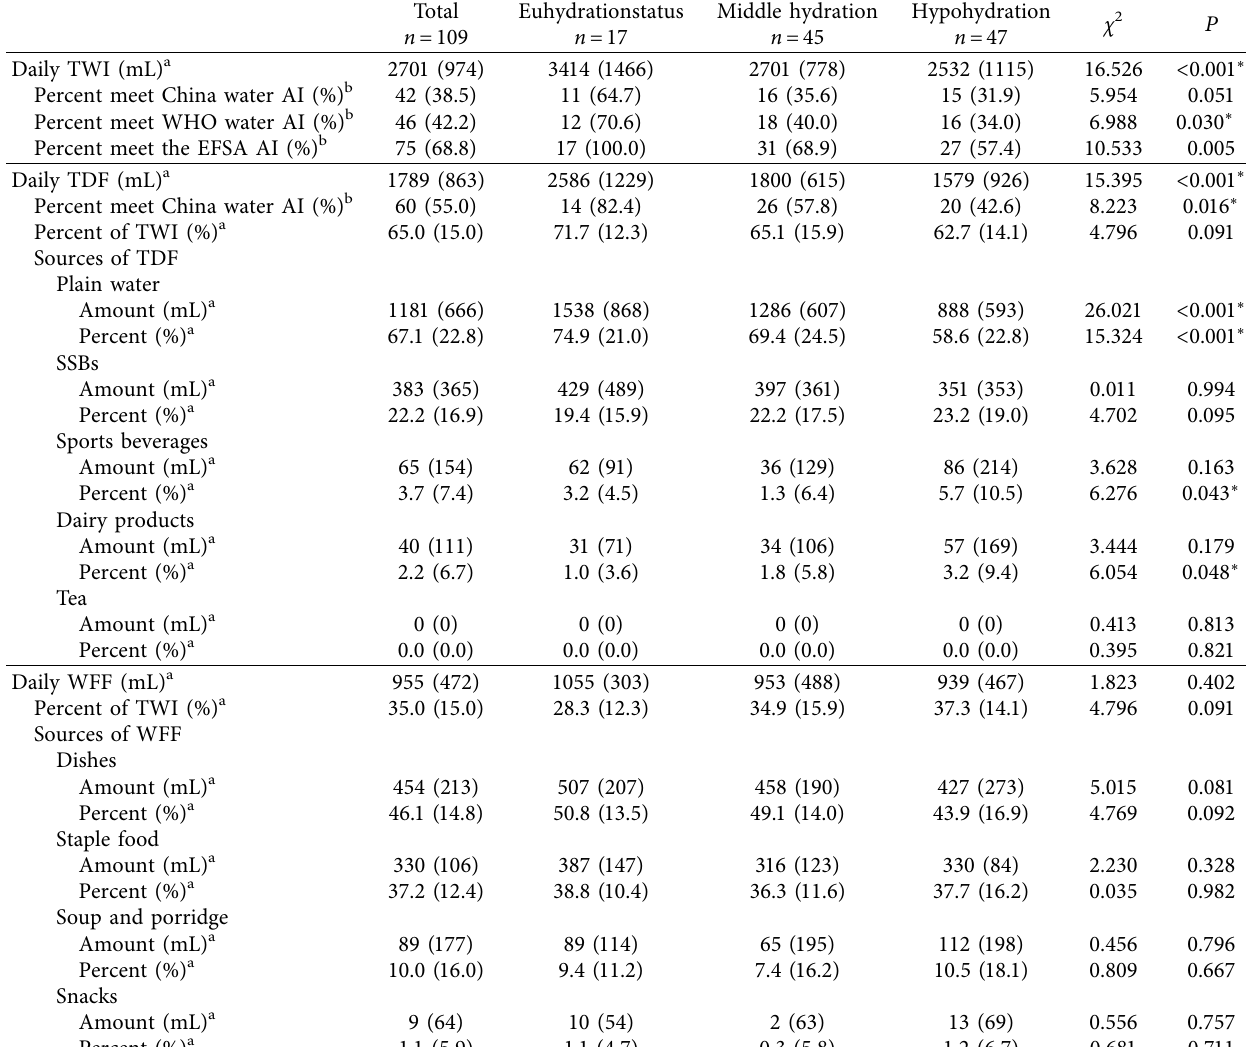
Table 3: Water intake of participants with different hydration